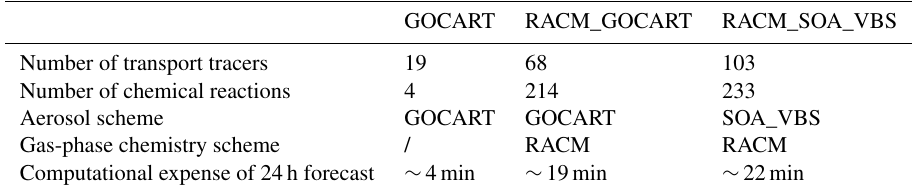
GOCART RACM_GOCART RACM_SOA_VBS